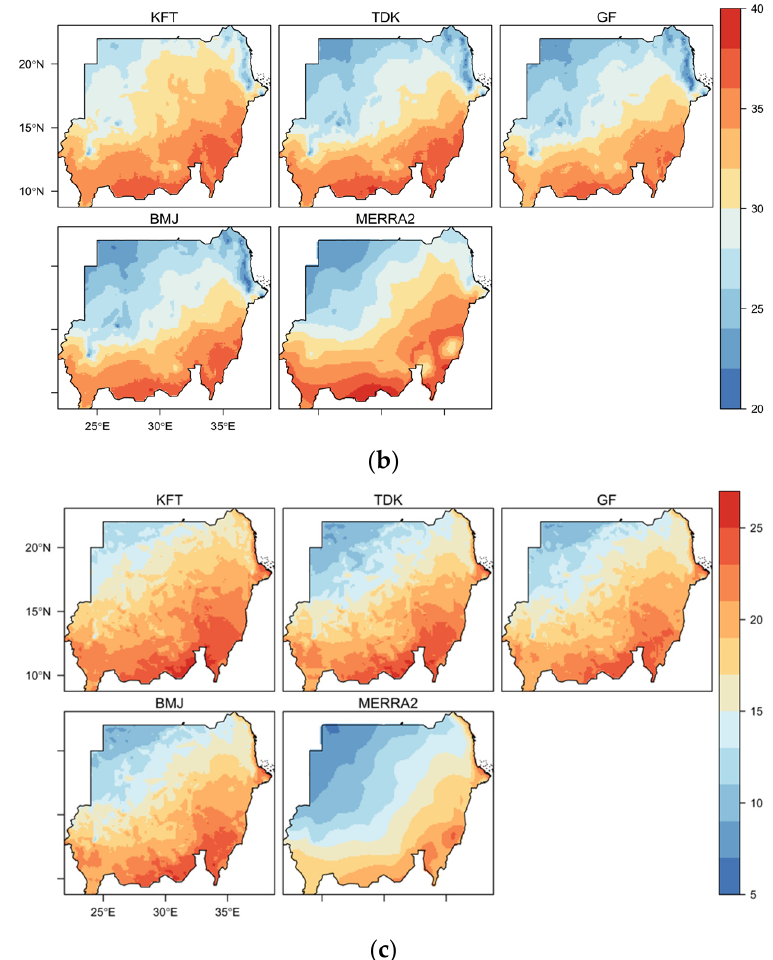
Figure 3. Spatial distributions of the 10-year seasonal (June–September) rainfall (mm) and seasonal (November–February) maximum and minimum temperatures (°C) simulated with the Betts–Miller– Janjic (BMJ), improved Kain–Fritch (KFT), modified Tiedtke (TDK), and Grell–Freitas (GF) schemes, and IMERG [50]-observed rainfall data and MERRA2 [51]-observed temperature data in Sudan. ( a ) Rainfall. ( b ) Maximum temperature. ( c ) Minimum temperature.